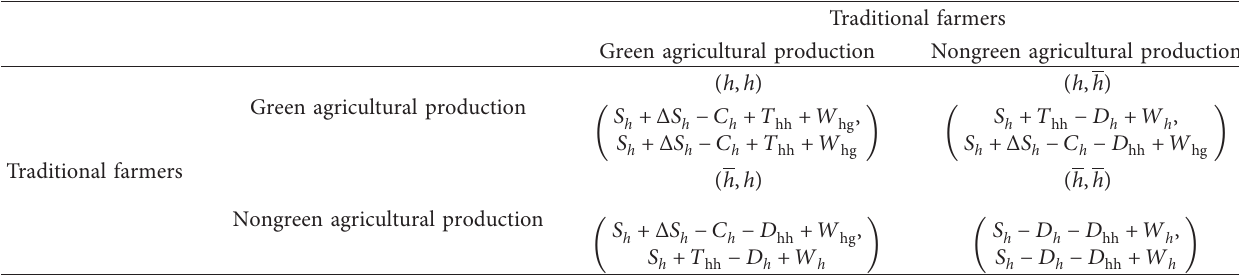
Table 5: The pairwise game matrix among traditional farmers under the government guidance mechanism.